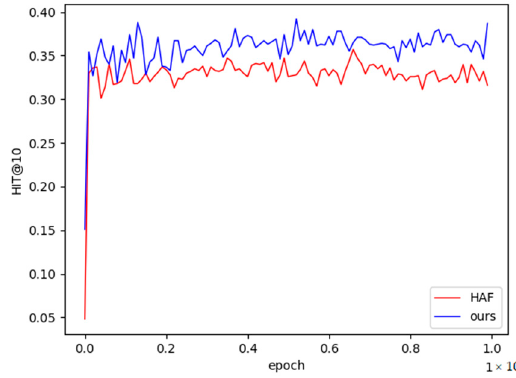
Figure 8. The 5-shot learning curve on NELL-One.